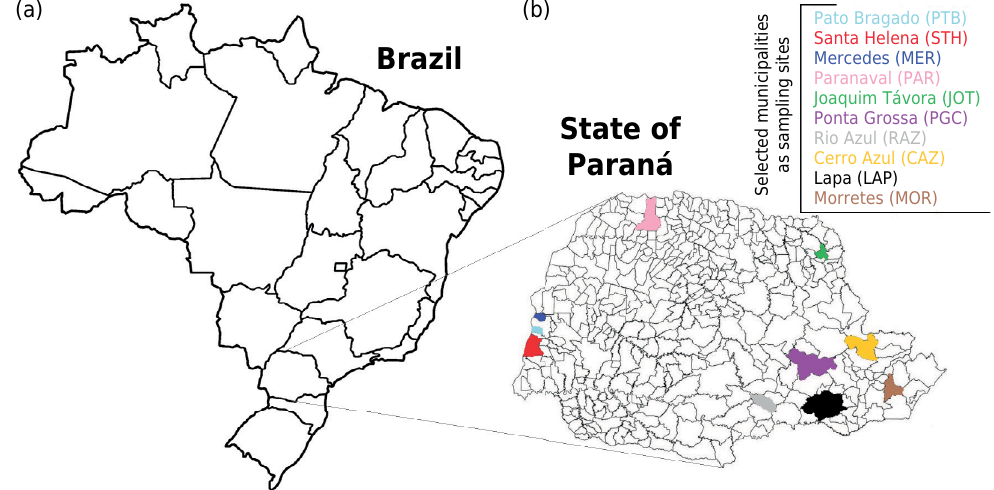
Figure 1. Map of Brazil locating the state of Paraná (a) and the municipalities’ location (b) where the soil samples were collected.